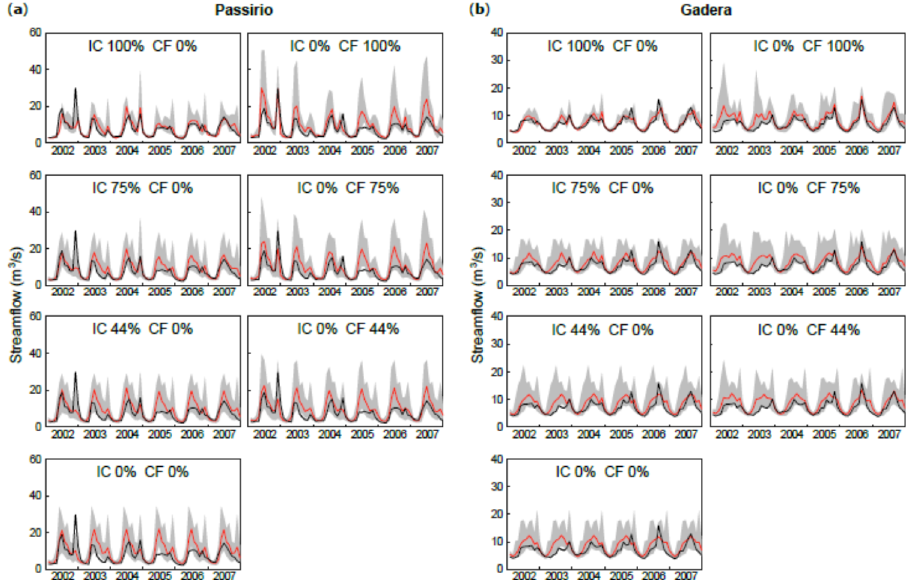
Figure 4. Chained time series of ensemble streamflow forecasts initialized on the first day of each month for varying levels of initial conditions (IC) and climate forcing (CF) skill (assuming null skill in the alternate predictability source), for lead time (LT) 1 month ( a ) over the Passirio catchment; and ( b ) over the Gadera catchment. The black line represents the surrogate streamflow observations created by the perfect simulation and the red line represents the forecast ensemble mean. The range of the forecast streamflow values (forecast spread) is shown by the grey 5th and 95th percentile band. Note the difference in the vertical axis between the two case studies.